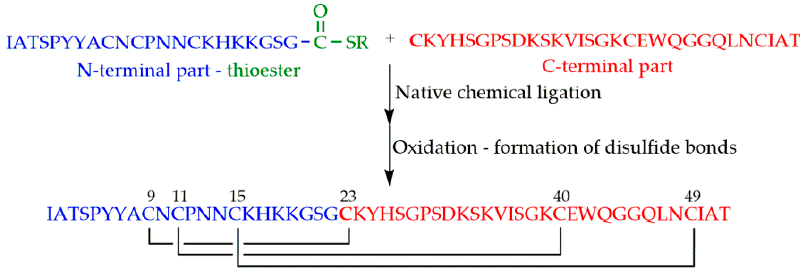
Figure 5. Synthesis of Neosartorya fischeri antifungal protein 2 (NFAP2) by native chemical ligation and subsequent